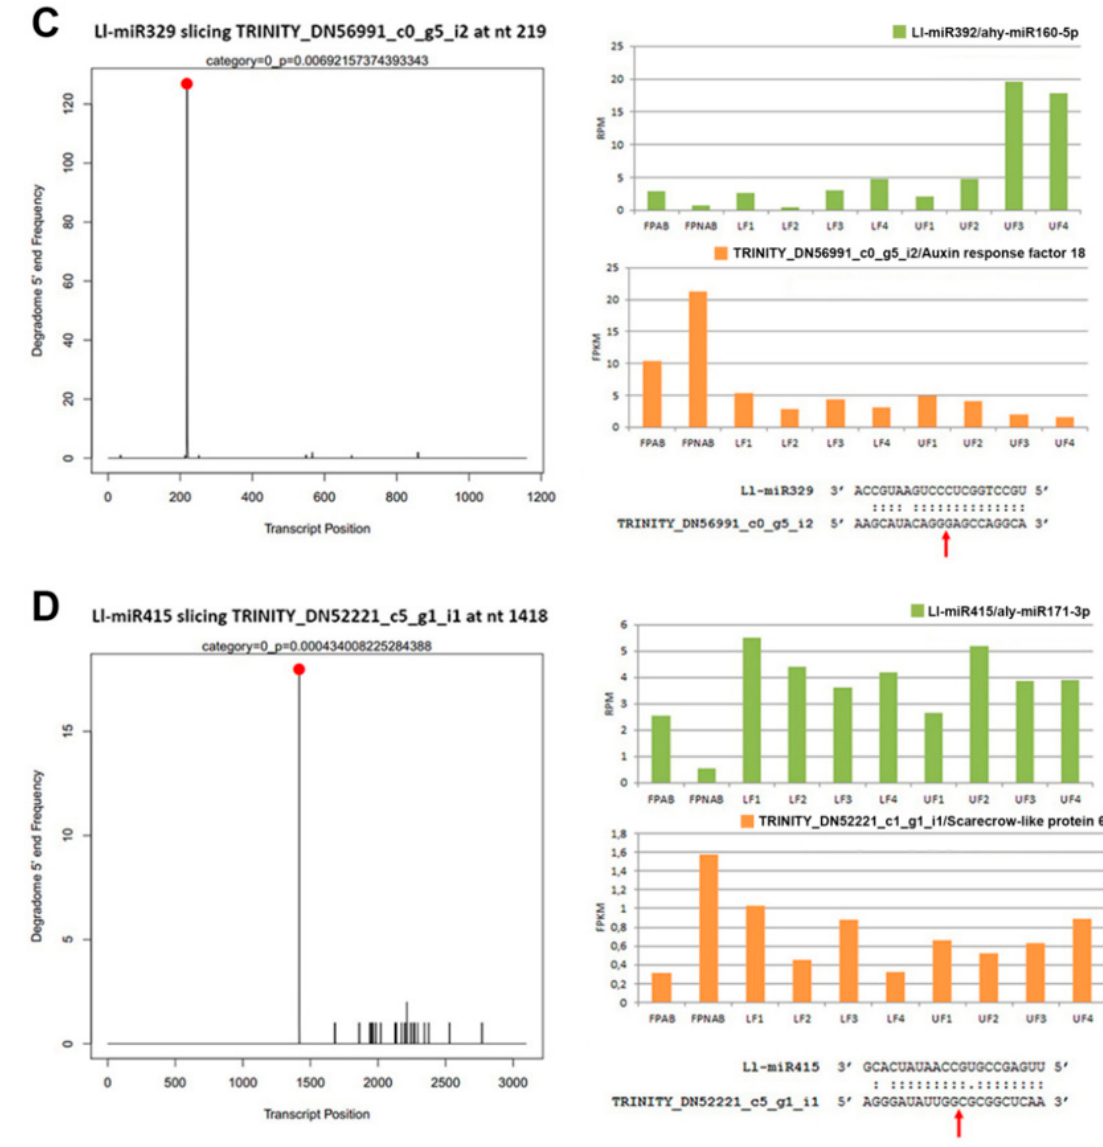
Figure 8. Examples of post-transcriptional regulation of miRNA targets in yellow lupine. ( A ) Ll-miRn1 and SGS3 mRNA, ( B ) Ll-miR102 and 2-methylacyl-CoA dehydrogenese mRNA, ( C ) Ll-miR392 and ARF18 mRNA, ( D ) Ll-miR415 and SCL6 mRNA. The T-plots show the distribution of the degradome tags along the full length of the target gene sequence. The cleavage site of each transcript is indicated by a red dot. Comparison of the expression levels of miRNAs and their targets in flowers from upper and lower whorls of yellow lupine racemes, and flower pedicels, as determined by deep sequencing. In miRNA-mRNA alignments, the red arrows indicate the cleavage site of the target gene transcript.